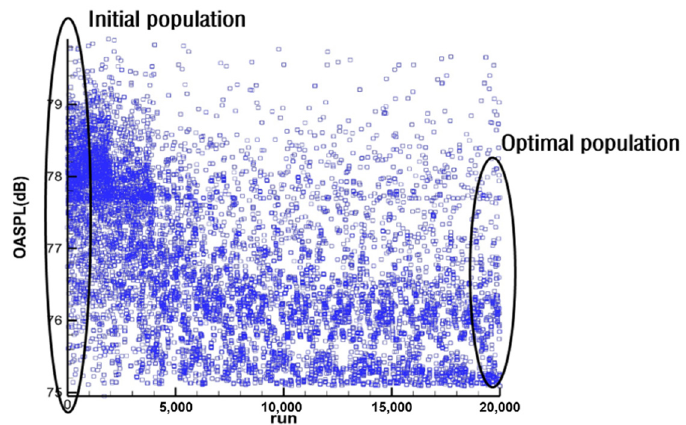
Figure 17. Variation of objectives in optimization process.